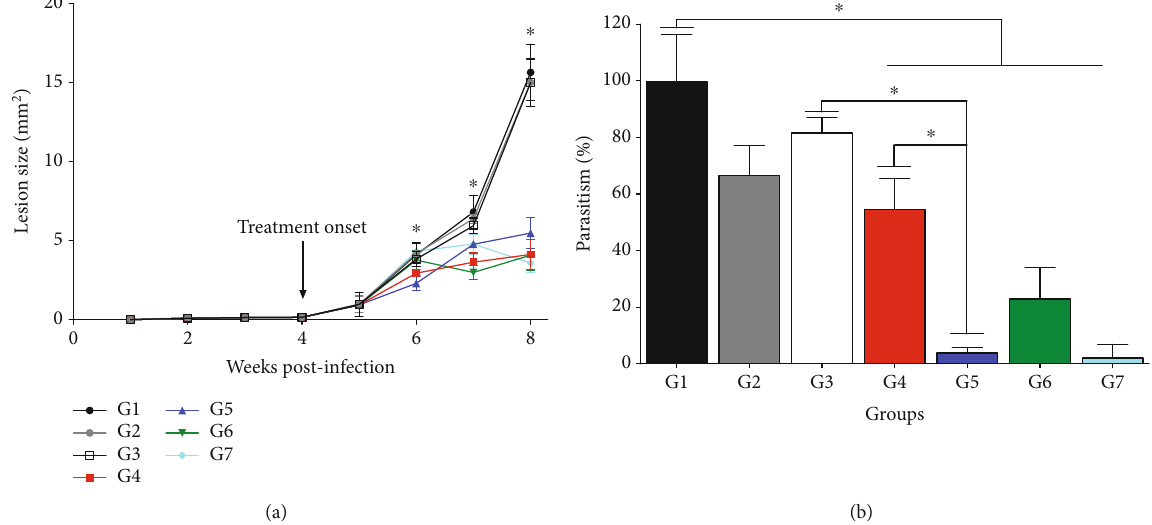
Figure 2: In vivo e ffi cacy of butena fi ne and nanoenabled formulations in experimental cutaneous leishmaniasis. BALB/c mice were infected into the base of the tail with 10 6 promastigote forms of L. (L.) amazonensis in stationary phase of growth. Four weeks after, infected animals were topically treated once daily for 15 days with blank SNEDDS, blank SNEDDS gel, BUT-SNEDDS, BUT-SNEDDS gel, butena fi ne, and Glucantime. Lesion sizes were analyzed weekly (a), and the skin parasitism from the base of tail, quanti fi ed by limiting dilution assay, was analyzed at 8 weeks of postinfection (b). ∗ p < 0 : 05 indicates statistical signi fi cance. G1: infected control; G2 and G3: animals treated with blank SNEDDS or blank SNEDDS gels, respectively; G4: animals treated with BUT-SNEDDS; G5: animals treated BUT-SNEDDS gel; G6: animals treated with butena fi ne; G7: animals treated with